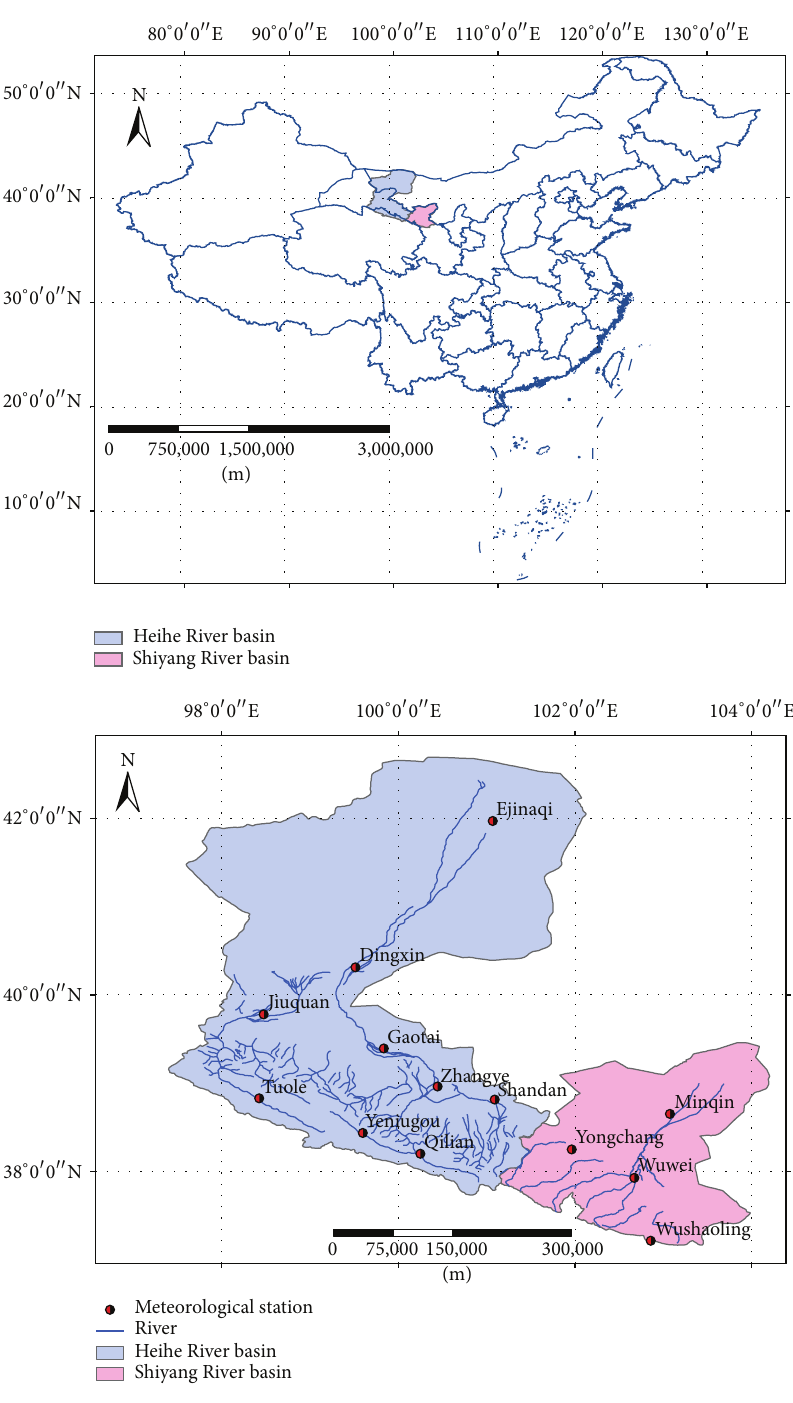
Figure 1: The locations of Heihe River basin and Shiyang River basin in China and the meteorological stations involved.